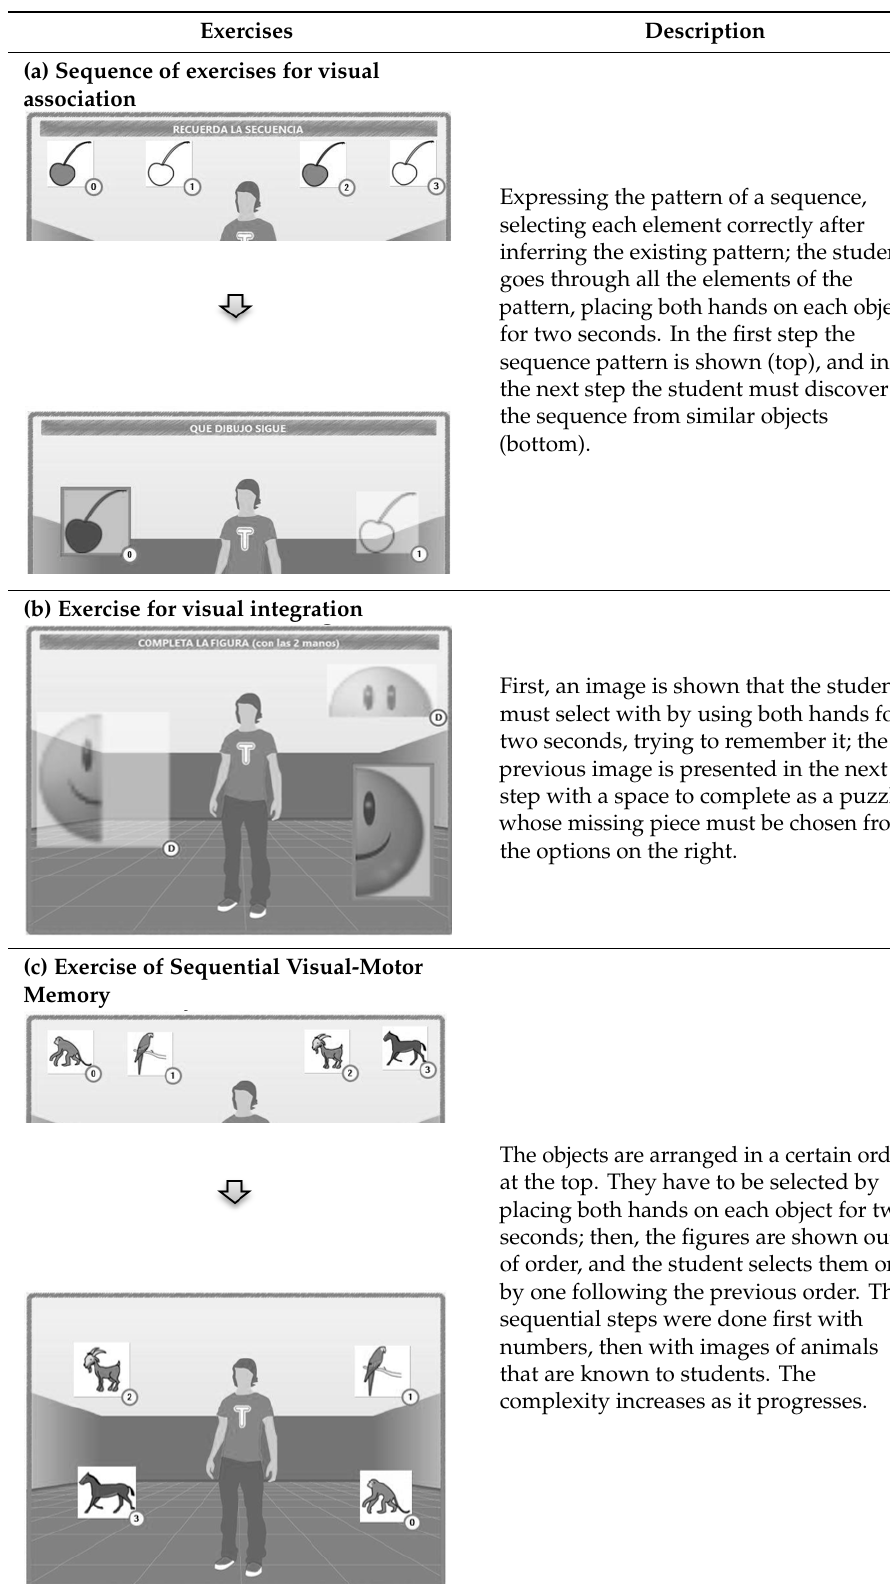
Table 3. Exercises for cognitive visual-motor stimulation.